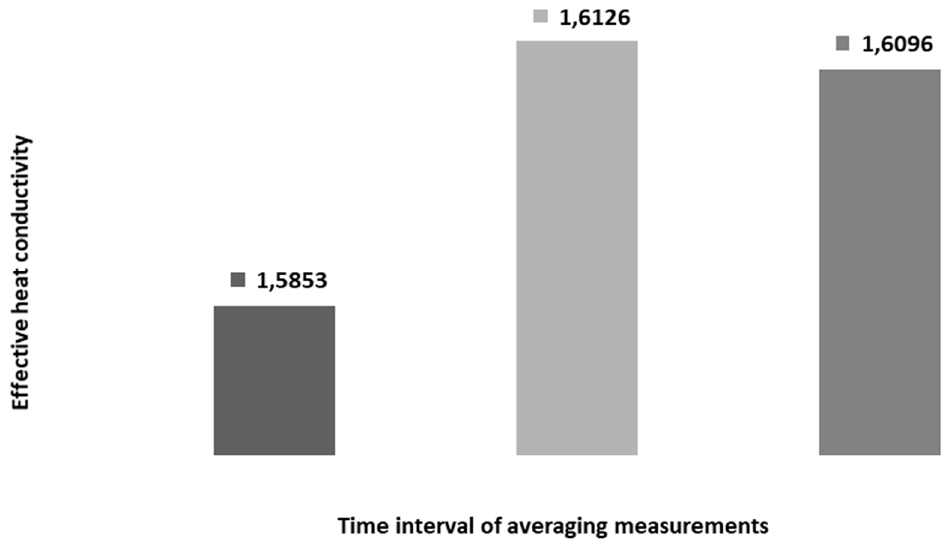
Figure 12. E ff ective thermal conductivity λ e ff depending on time interval for BHE-1 Figure 12. Effective thermal conductivity λ eff depending on time interval for BHE-1 (coaxial).